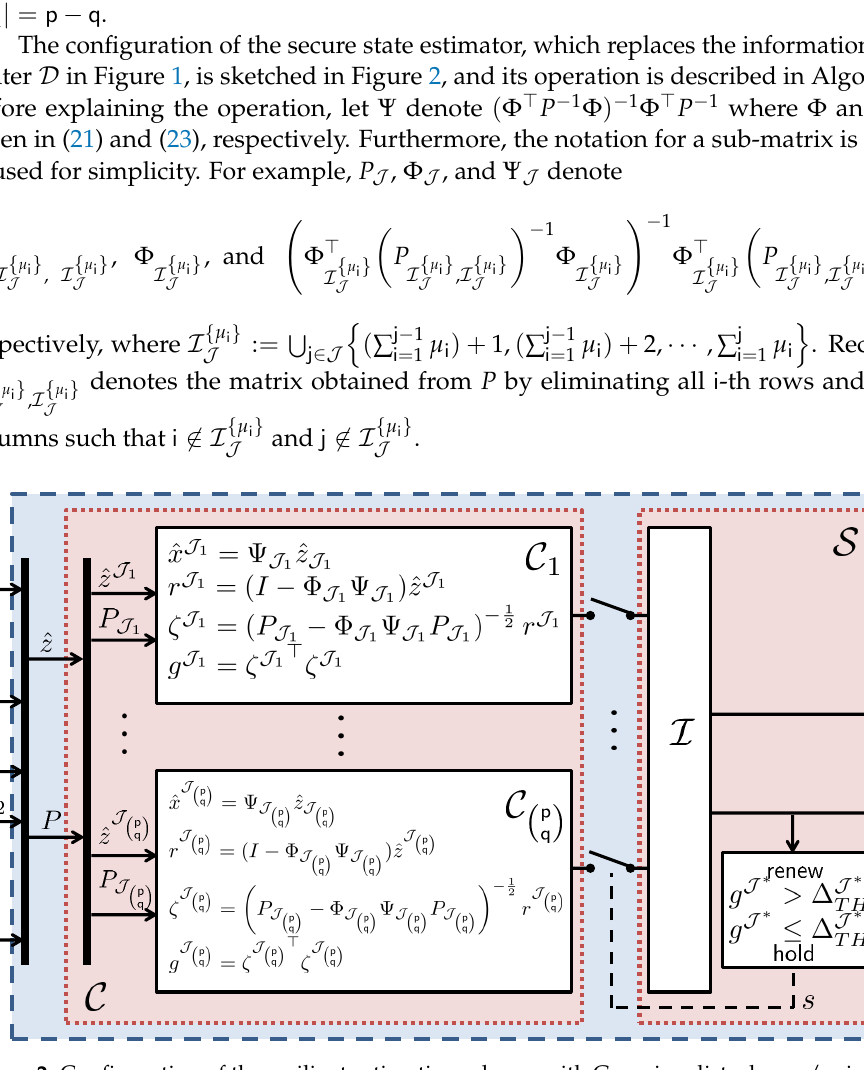
Figure 2. Configuration of the resilient estimation scheme with Gaussian